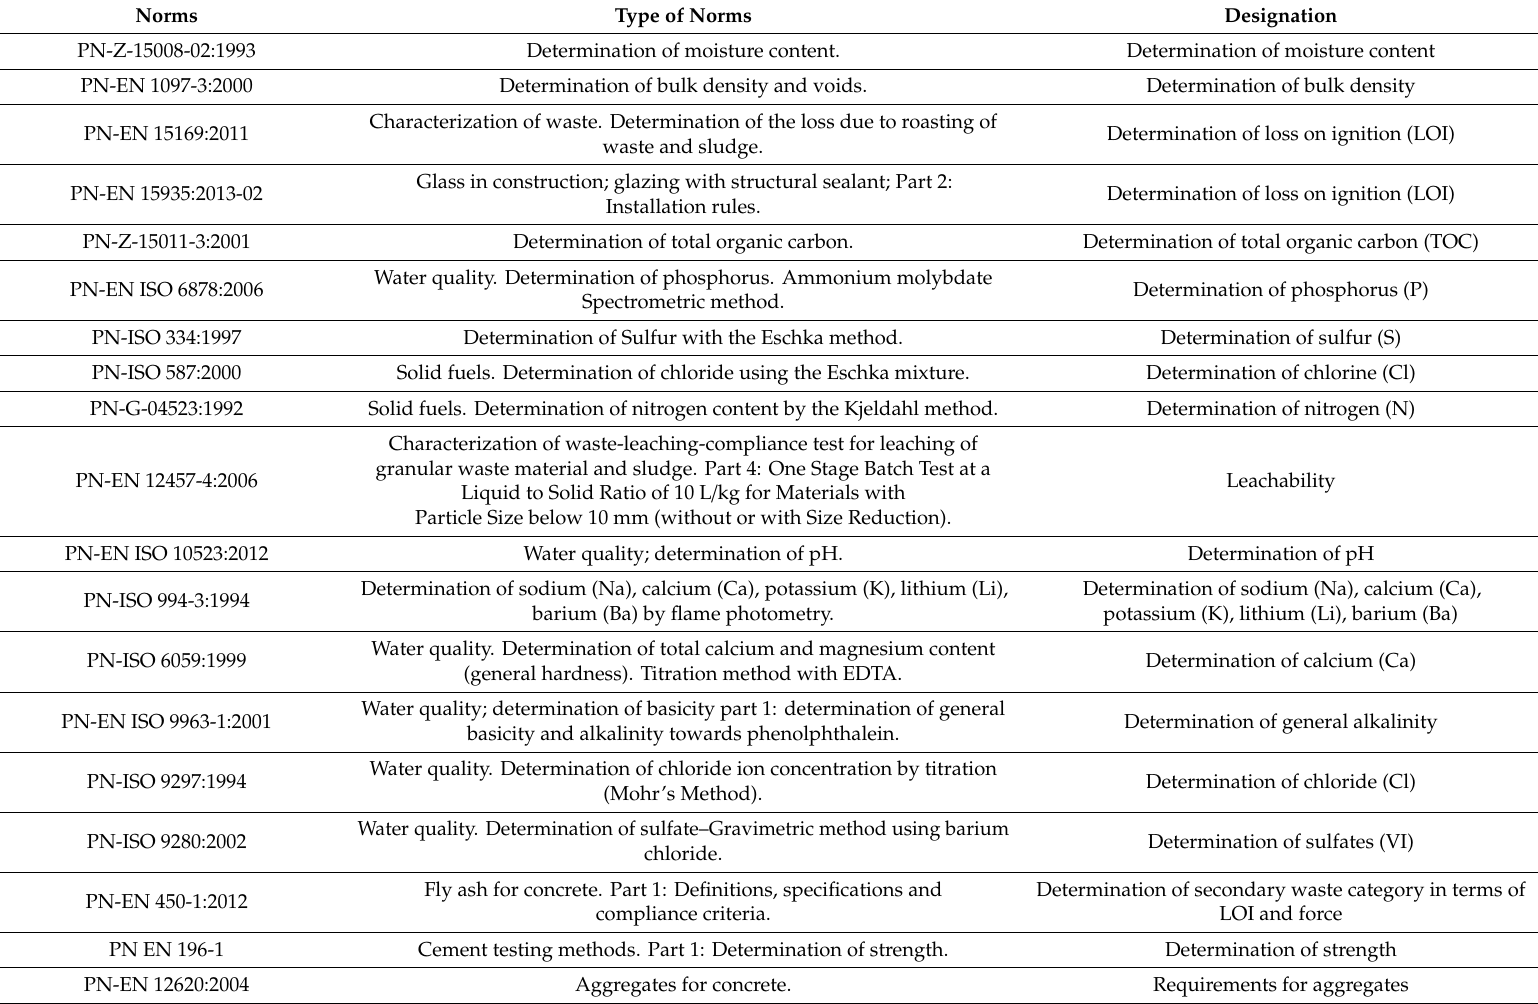
Table 2. Standards, according to which tests were carried out